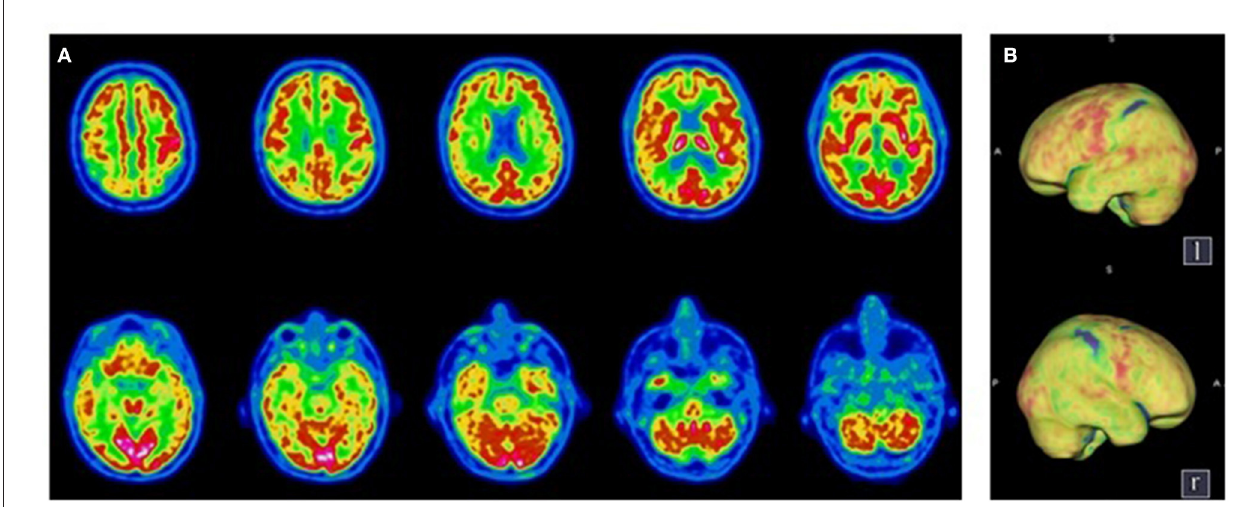
FIGURE 2 | Transaxial (A) and Volume Rendered Brain (B) 18 F-FDG PET. Diffuse cortical hypometabolism predominant in the right hemisphere, with a preservation of the primary sensorimotor areas. Normal metabolism of the sub-cortical structures and the cerebellum. extended confusion after sedation withdrawal and impaired consciousness